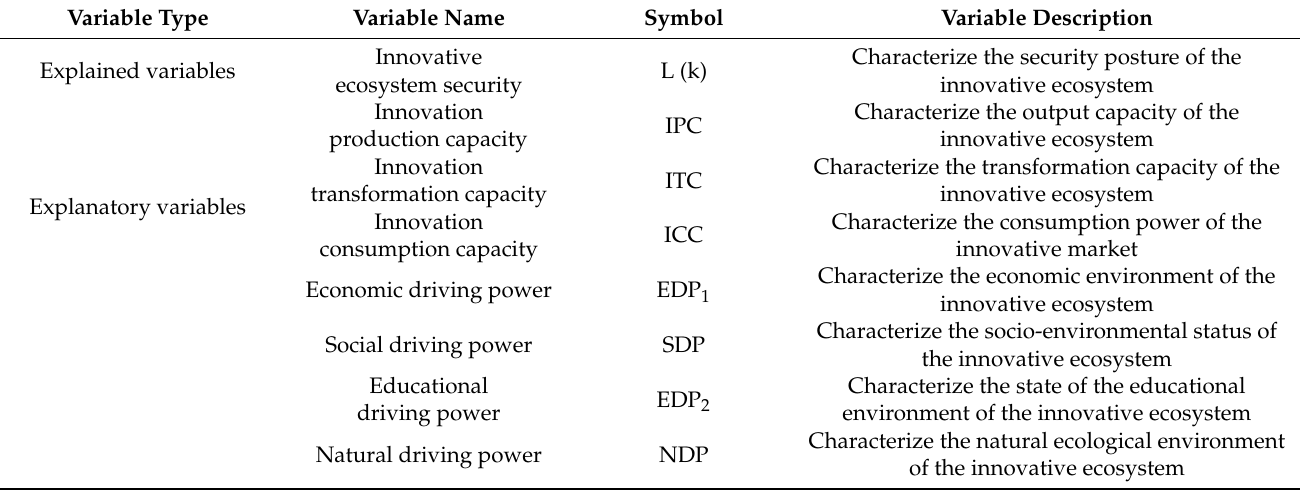
Table 5. Security driving factors analysis variable